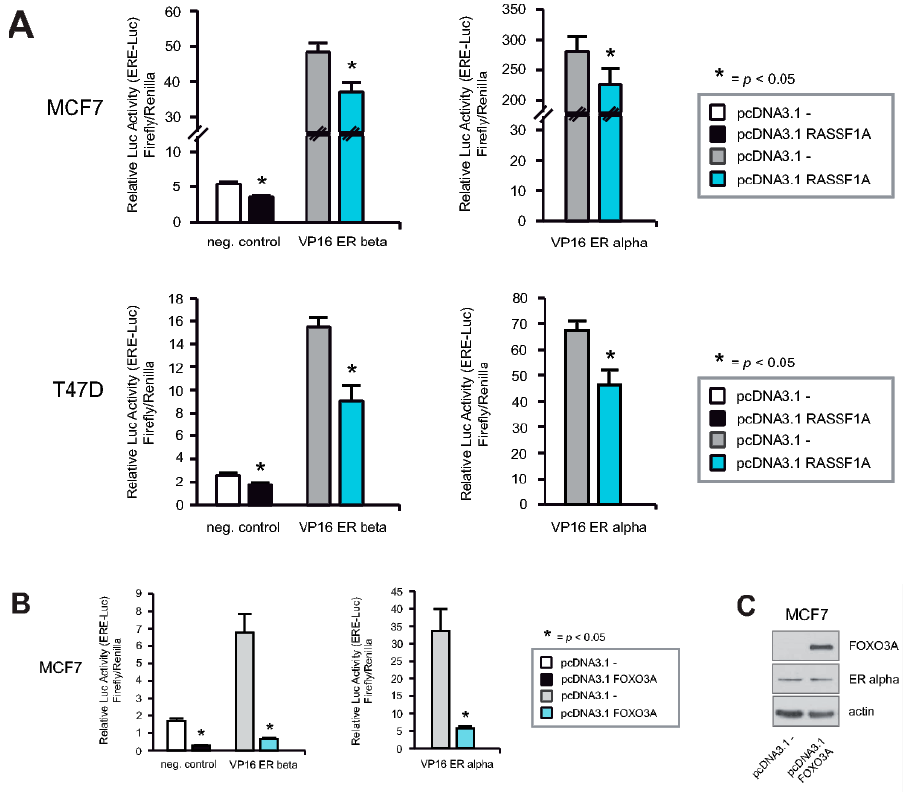
Figure 6. RASSF1A and FOXO3A cause decreased ER α and ER β activity. ( A ) Parental MCF7 cells (upper panel) and parental T47D cells (lower panel) were co-transfected with a RASSF1A expression construct or empty vector together with either ER α [37] or ER β [37] and an ER luciferase reporter